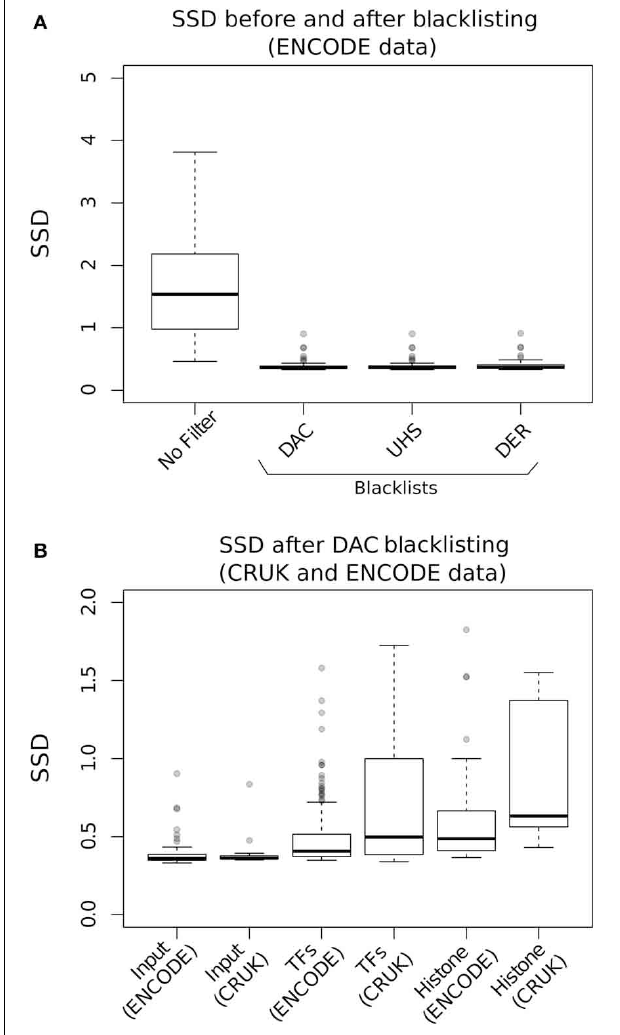
FIGURE 3 | (A) The Boxplots show the range of SDD values for CRUK and ENCODE/SYDH input samples with no filtering steps applied and after filtering of signal from DAC consensus, UHS, and DER blacklists. (B) Boxplots of the SSD scores for input, transcription factors (TFs) and histone marks from ENCODE and CRUK datasets following blacklisting by the DAC consensus